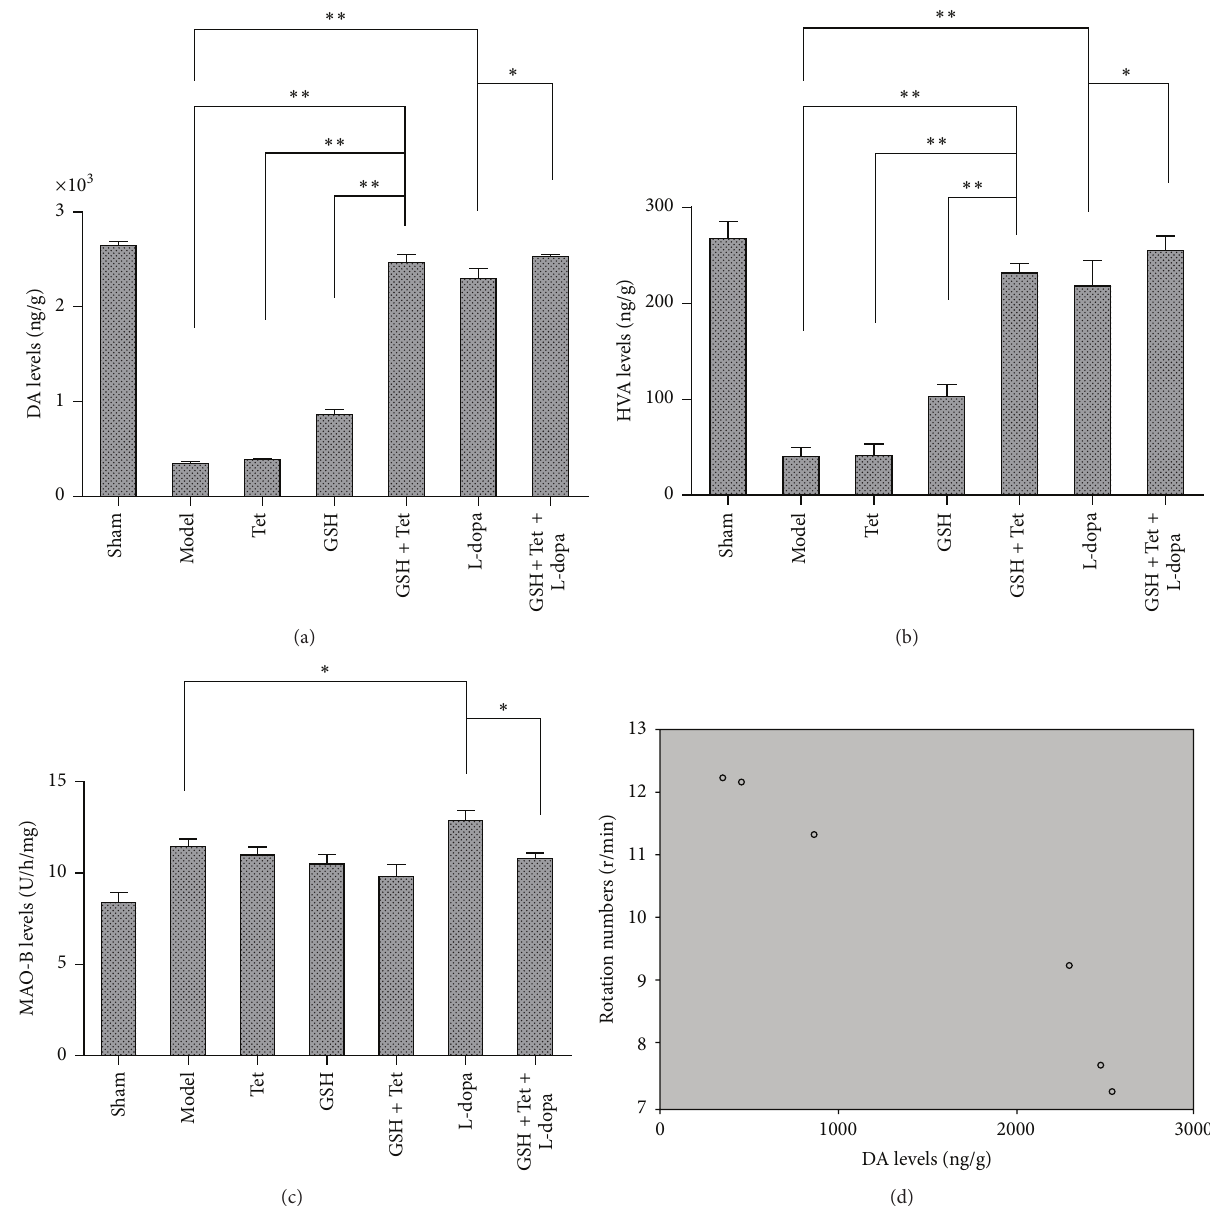
Figure 2: Effects on the concentration of dopamine (DA) (a), homovanillic acid (HVA) (b), and monoamine oxidase B (MAO-B) (c) in the striatum of lesion sides and the correlation between DA levels and rotational behavior induced by APO (d). Each bar represents mean ± standard deviation (SD) for six animals per group. ∗ 𝑝 < 0.05 , ∗∗ 𝑝 < 0.01 comparison among different groups after drug